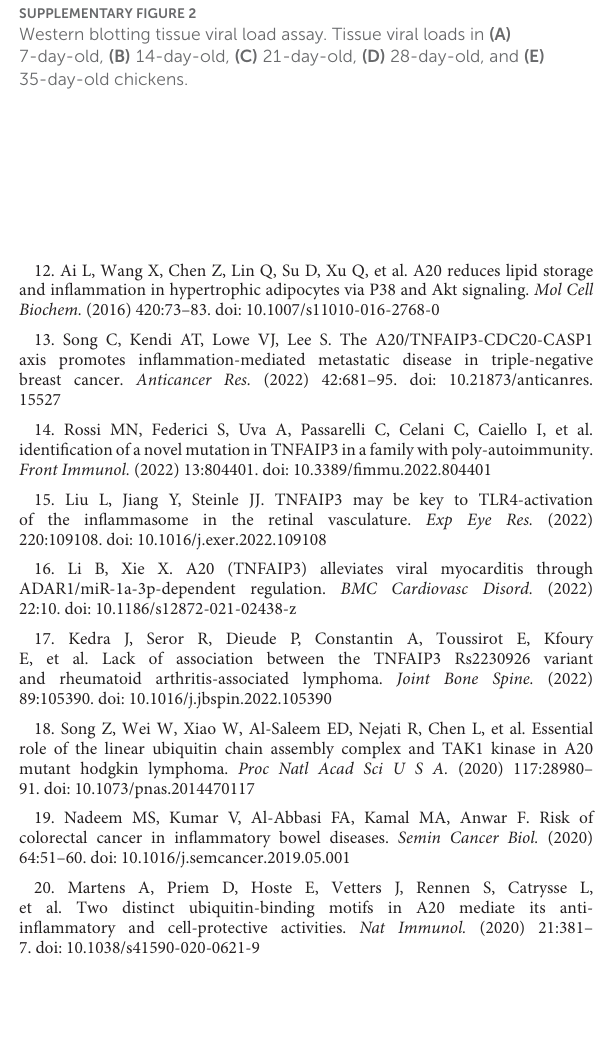
SUPPLEMENTARYFIGURE1 Validation of 40-week-old chicken liver RNA-seq sequencing and qRT-PCR results. SUPPLEMENTARYFIGURE2 Western blotting tissue viral load assay. Tissue viral loads in (A) 7-day-old, (B) 14-day-old, (C) 21-day-old, (D) 28-day-old, and (E) 35-day-old